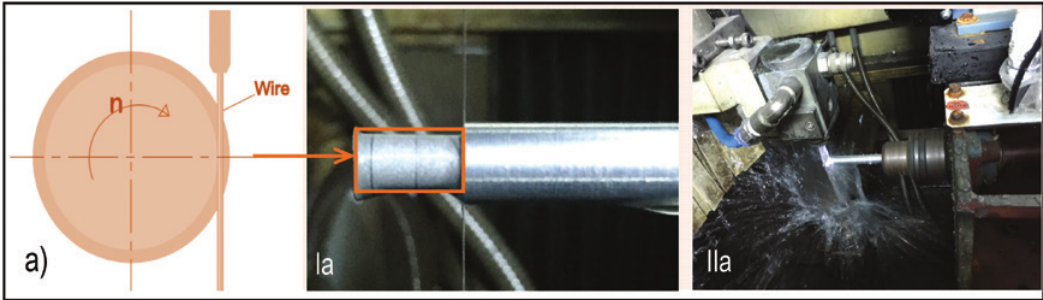
Figure 3: Turning mechanism and turning operation performed on hybrid MMC.